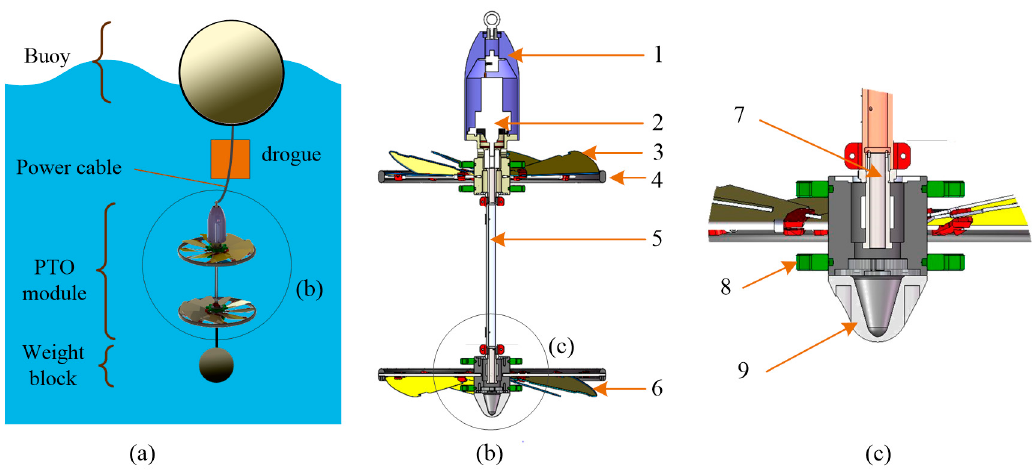
Figure 8. Design concept and mechanical structure: ( a ) schematic diagram of the design concept; ( b ) section view of the mechanical structure (1. water shield; 2. direct current (DC) generator; 3. upper blade group (UBG); 4. caging device; 5. supporting tube; 6. lower blade group (LBG)); ( c ) partial section view of mechanical structure (7. transmission shaft; 8. adjustable ring for blade angle; 9. water shield).